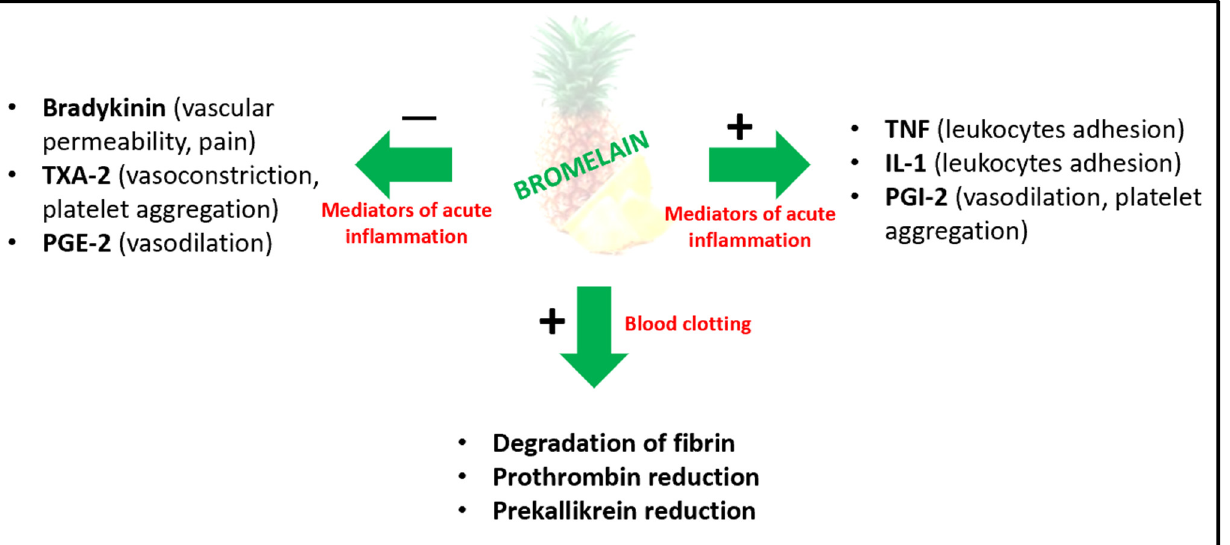
Figure 2. Bromelain anti-inflammatory and anticoagulant mechanisms of action.